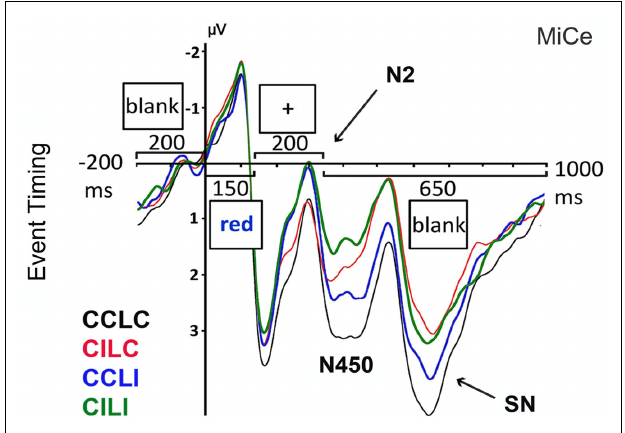
FIGURE 3 |The timing of paradigm events in Experiment 2, overlaid on grand average ERPs at electrode MiCe (vertex) time-locked to the onset of the visually presented